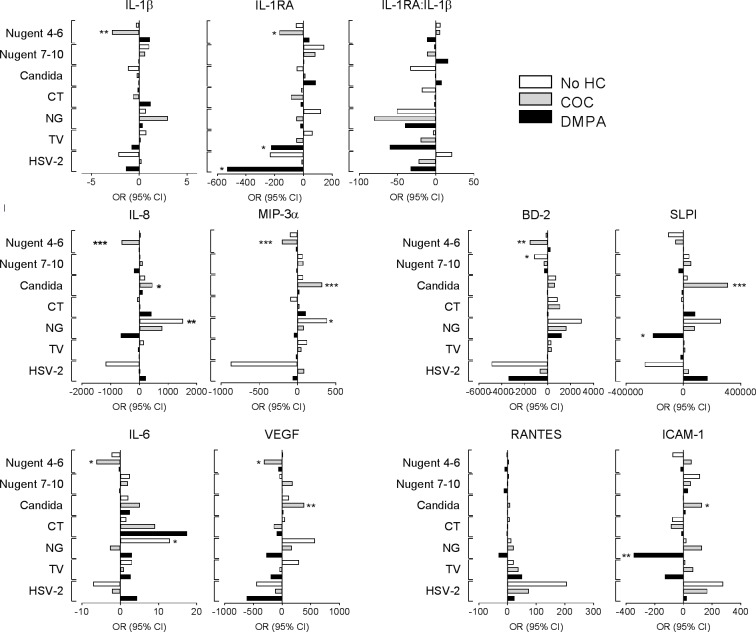
Changes in cervical immunity from before to after acquisition of cervicovaginal infections (CVIs) stratified by hormonal contraceptive use (no HC, DMPA and COC) and adjusted for site, age, pregnancy, breastfeeding, overlapping CVIs, unprotected sex and vaginal practices.CVIs include: (1) vaginal dysbiosis defined by Nugent 4–6, Nugent 7–10 or a positive test for candida, and (2) sexually transmitted infections positive for Chlamydia trachomatis (CT), Neisseria gonorrhoeae (NG), Trichomonas vaginalis (TV) or genital herpes (HSV-2). Horizontal axis represents averages of individual level differences in pg biomarker per ml cervical elution adjusted to mg/ml total protein. The concentration of each biomarker at the visit preceding each CVI is set to 0 on the X axis of each bar plot; bars to the left represent decreased and bars to the right–increased levels at the time of CVI incidence. Number of incident infections: Nugent 7–10 –no HC = 56, DMPA = 98, COC = 97, Nugent 4–6 –no HC = 53, DMPA = 107, COC = 112, TV–no HC = 12, DMPA = 13, COC = 11, Candida—no HC = 33, DMPA = 66, COC = 68, CT–no HC = 9, DMPA = 10, COC = 13, GC–no HC = 11, DMPA = 18, COC = 10, HSV-2 –no HC = 5, DMPA = 5, COC = 8. Visits with any missing diagnostic test were excluded. *, p<0.05, **, p<0.01, ***, p<0.001.